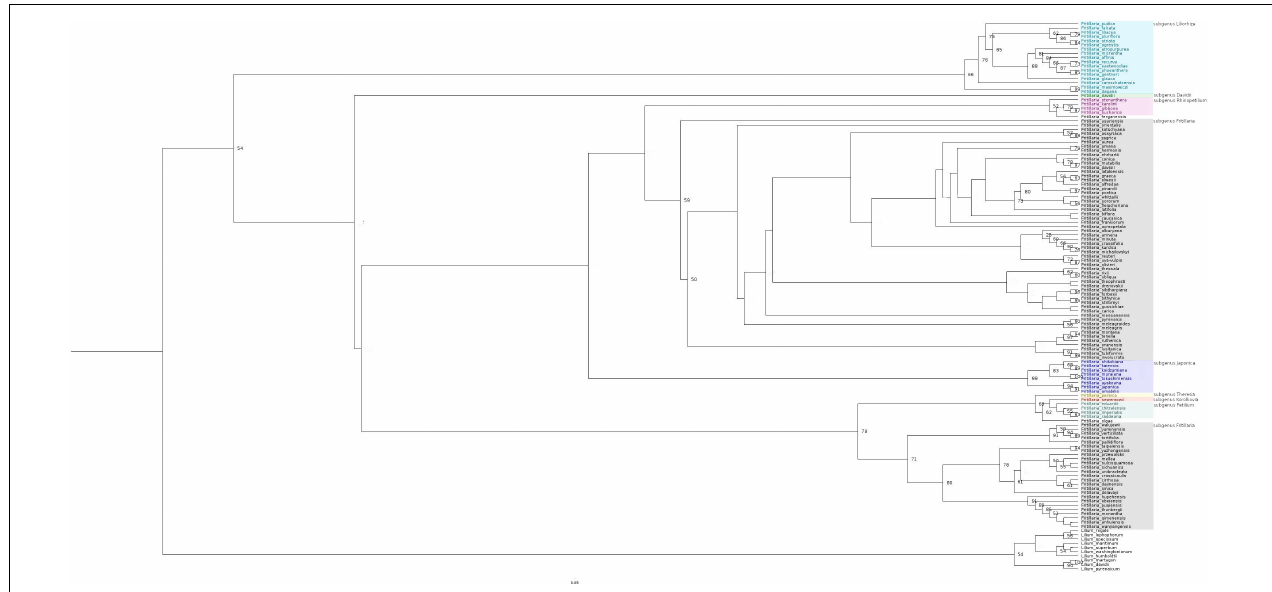
FIGURE 2 | Maximum likelihood tree inferred from analysis combined of five DNA markers: plastid genome ( matK, rpl16 , and rbcL ), nuclear (18S), and internal transcribed spacer (ITS) sequences. The bootstrap values are given along the branches (only values > 50 presented). Species representing different subgenera marked with different colours. Species not classified to any subgenus are left